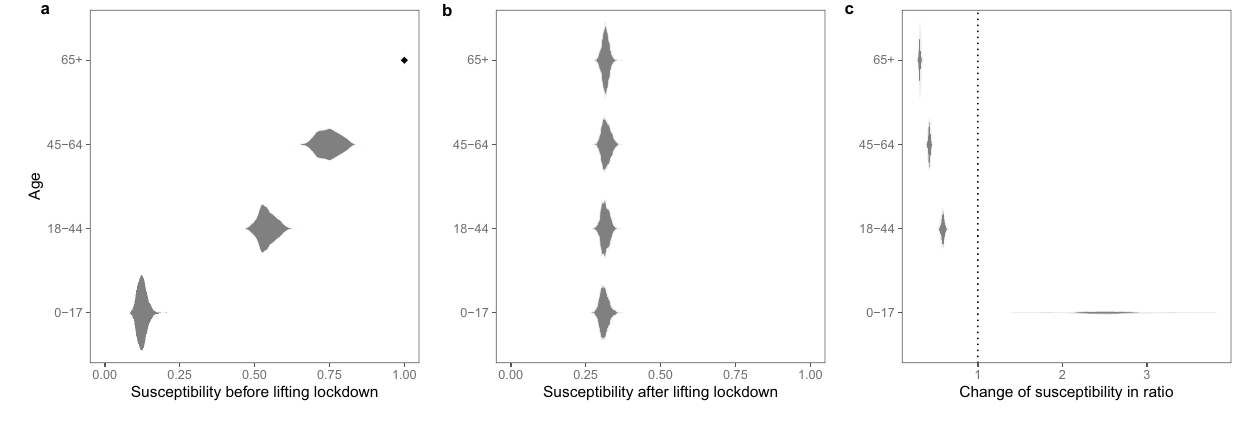
Figure 2. Posterior distributions of age-specific susceptibility. ( a ) Age-specific susceptibility before lifting the lockdown. Note that susceptibility is measured relatively to the 65+ years whose susceptibility parameter is set to be 1. ( b ) Age-specific susceptibility after lifting the lockdown. ( c ) Changes of susceptibility. Change for a particular age group is measured by the ratio between the post-lockdown estimate and the estimate obtained for the period prior to lifting the lockdown.